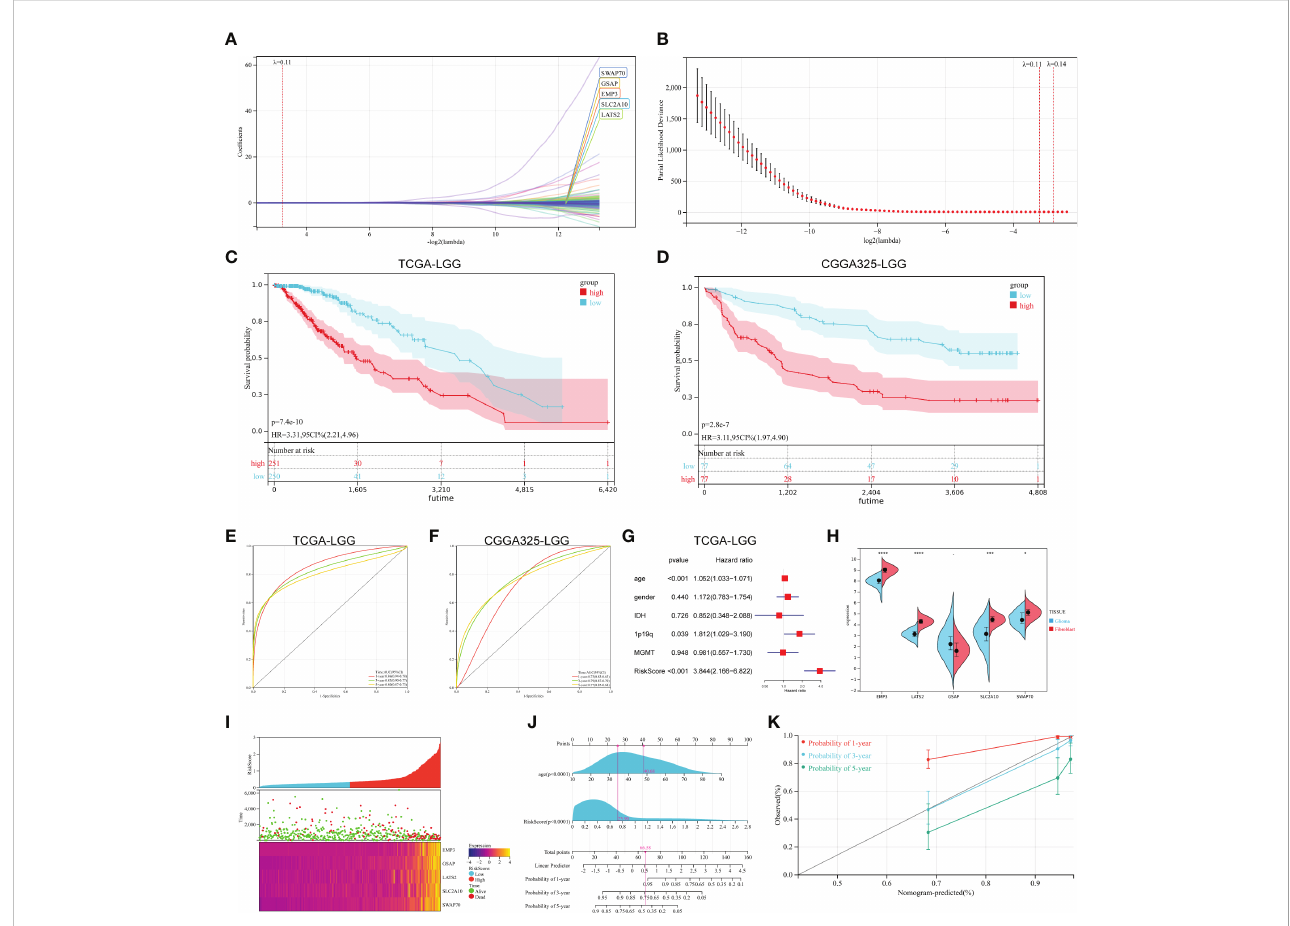
FIGURE 4 Construction of prognostic signature. (A, B) The process of building the signature. The least absolute shrinkage and selection operator ( LASSO ) regression was performed, calculating the minimum criteria. (C, D) K-M curves showed that the high-risk subgroup had worse overall survival than the subgroup in the train set ( p< 0.001 ) and test set ( p< 0.001 ) . (E, F) ROC curves showed the predictive ef fi ciency of the risk signature on the 1-, 3- and 5- year survival rates of train set (E) and test set (F) . (G) Independent prognostic factors were determined by the multivariate Cox regression analyses. (H) Expression of fi ve risk genes in fi broblast cell lines and glioma cell lines in the CCLE dataset. (I) The heatmap was based on the expression of the fi ve genes in the high- and low-risk group. (J, K) A nomogram (J) and decision curve analysis (K) of the risk score for predicting 1-, 3- and 5-year survival. (*p < 0.05, **p <0.01, ***p <0.001, ****p